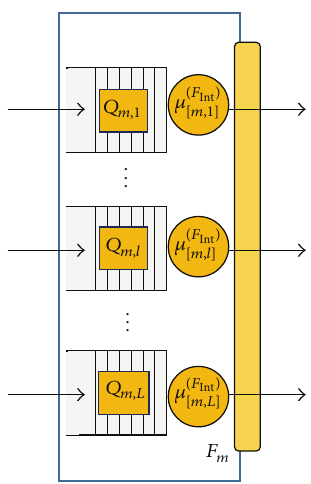
Figure 3: Block diagram of the generic function 𝐹 𝑚